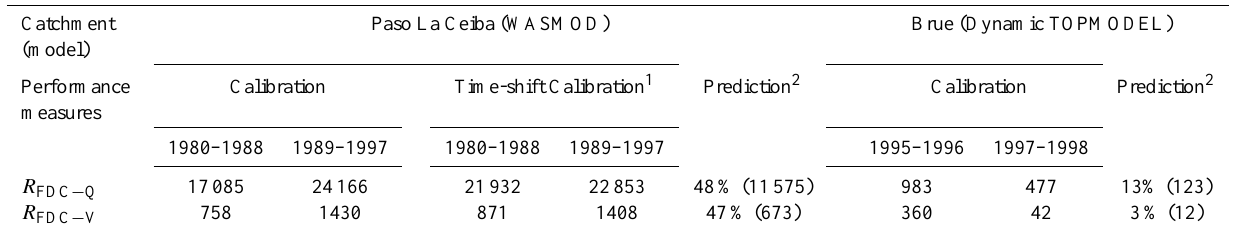
Fig. 6. Observed crisp and uncertain FDCs for the Paso La Ceiba catchment, (a–b) upper and lower flow range respectively and for the Brue catchment, (c–d) upper and lower flow range respectively. The extreme FDC represents the maximum and minimum uncertain FDC for all consecutive 9- and 2-yr periods for the Paso La Ceiba and Brue catchment respectively. The FDC-V represents volume interval EPs and FDC-Q discharge interval EPs (only plotted for the last period in each catchment). The high and low flows of the FDCs are plotted separately for better visualisation; note the difference in scale on the y-axis. Table 3. Number of behavioural parameter-value sets for the different FDC performance